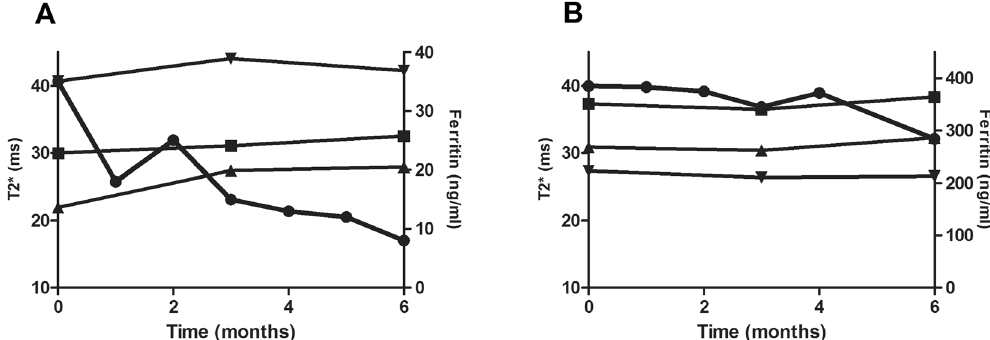
Figure 5. Examples of changes in ferritin levels and T2 * values in two PD patients receiving chelation therapy for 6 months. ( A ) Plasma ferritin level < 100 ng/ml at the beginning of the study ( B ) plasma ferritin level > 300 ng/ml. Ferritin values are denoted by circles, caudate nucleus T2 * values by upright triangles, dentate nucleus values by downward triangles and substantia nigra by squares.